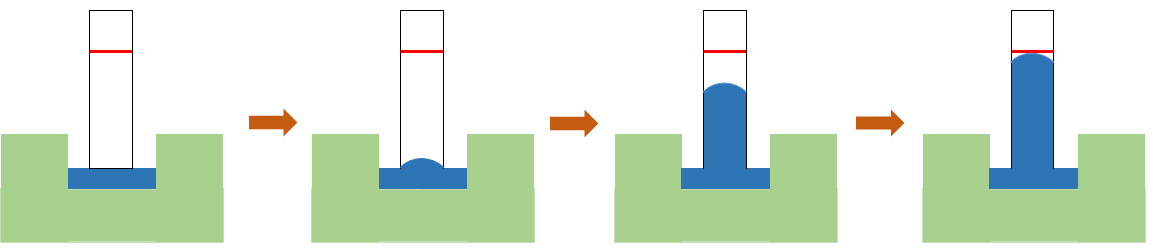
Figure 3. Diagram of capillary flow rate test.